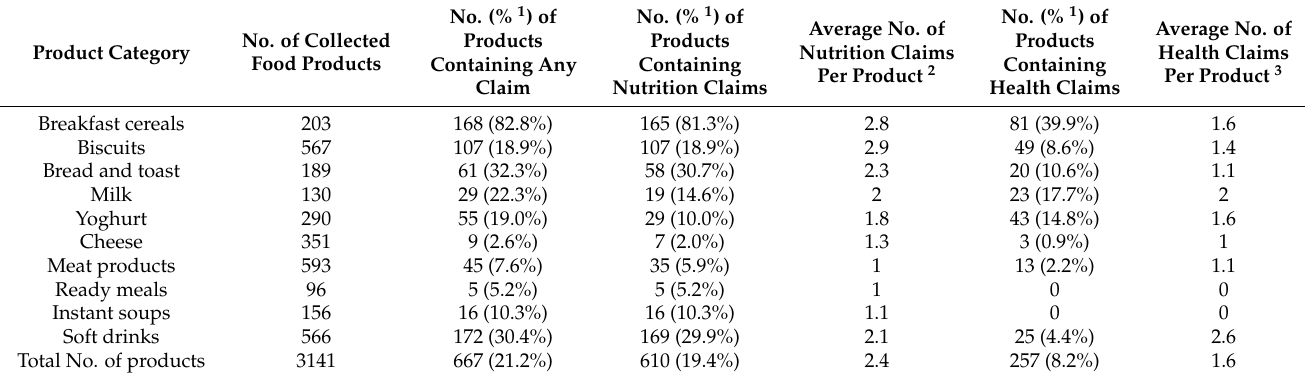
Table 2. Number of collected food products, the number (proportion) of food products containing NHCs, and the average number of NHCs by product